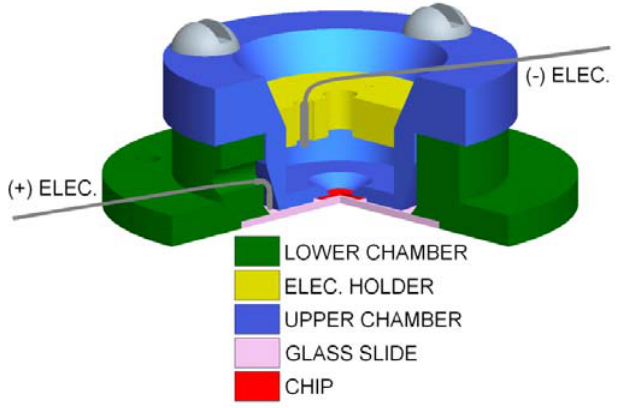
Figure 3. Rendering of experimental flow cell with a 90  radial cut-away for cross- sectional view. Upper chamber (blue), electrode supporting ring (yellow), low chamber (green), micropore chip (red), and glass slide